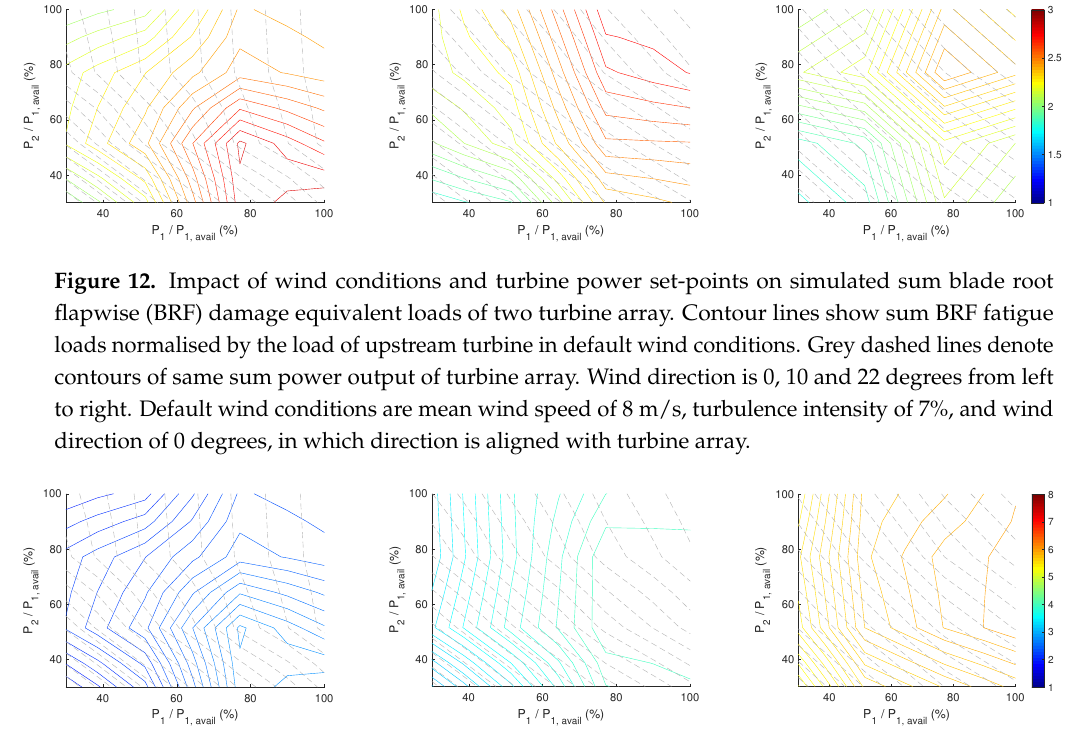
Figure 13. Impact of wind conditions and turbine power set-points on simulated sum BRF damage equivalent loads of two turbine array. Contour lines show sum BRF normalised fatigue loads. Ambient turbulence intensity is 7%, 14% and 27% from left to right.